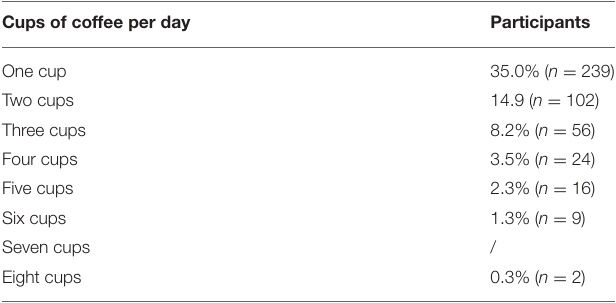
TABLE 8 | Daily cups of